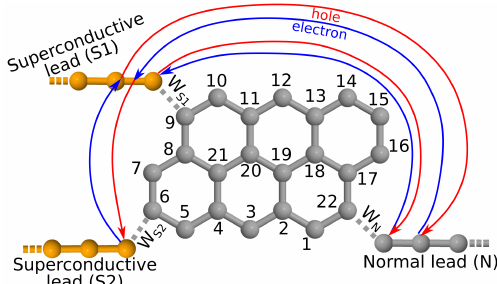
Figure 2. Anthanthrene molecule attached to two superconductive and one normal lead. The connectivity matrix element between the sites 6 and 22 is zero, while the connectivity between sites 9 and 22 and between sites 9 and 6 is finite. Solid lines indicate the propagation of the electron-like (blue) and hole-like (red)